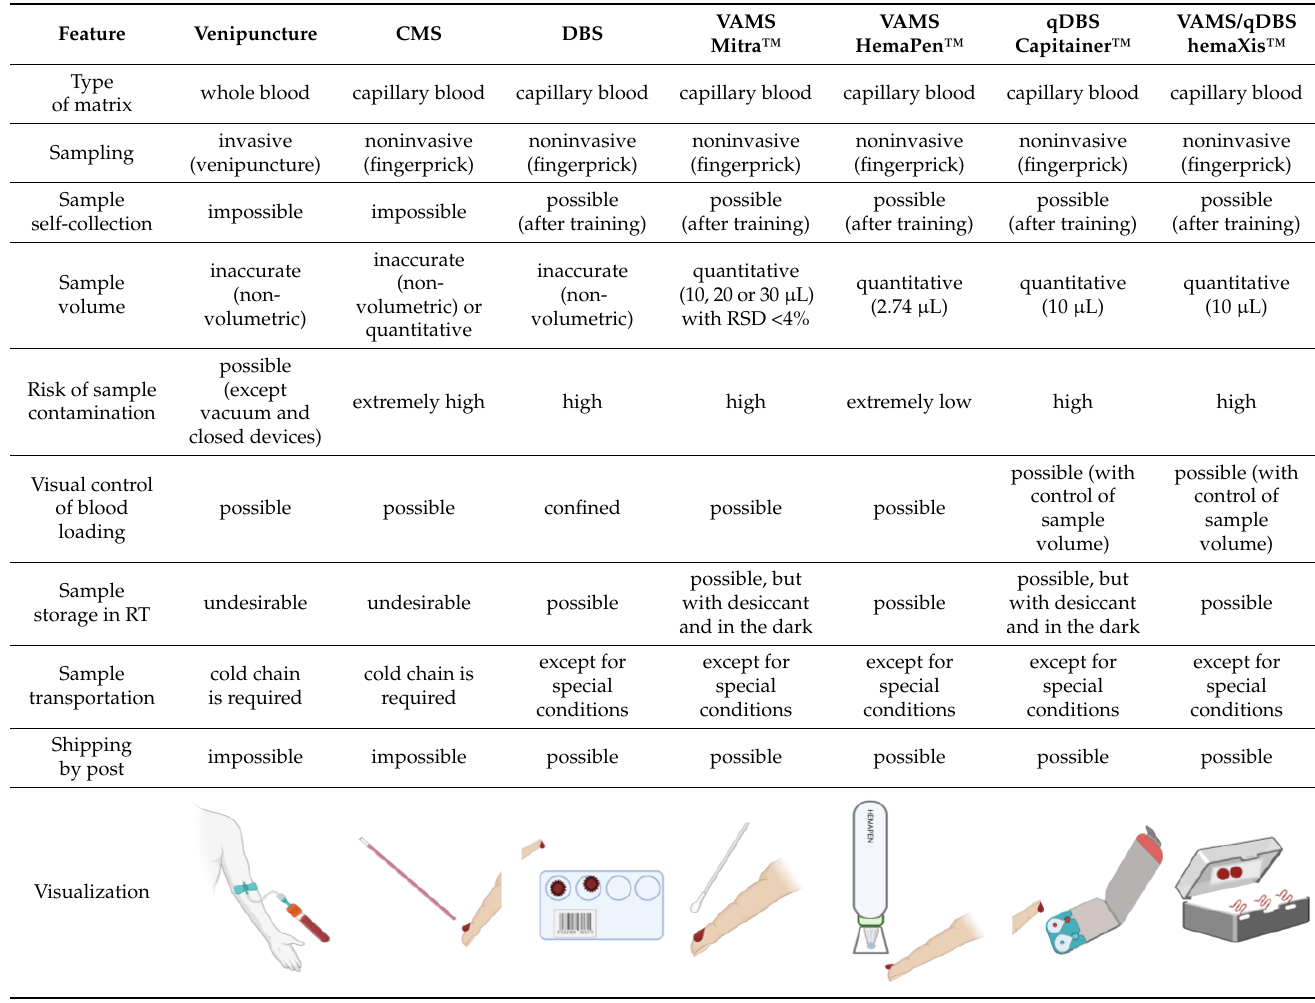
Table 5. Selected alternative microsampling techniques summarise the characteristics and compare them with the reference venipuncture method